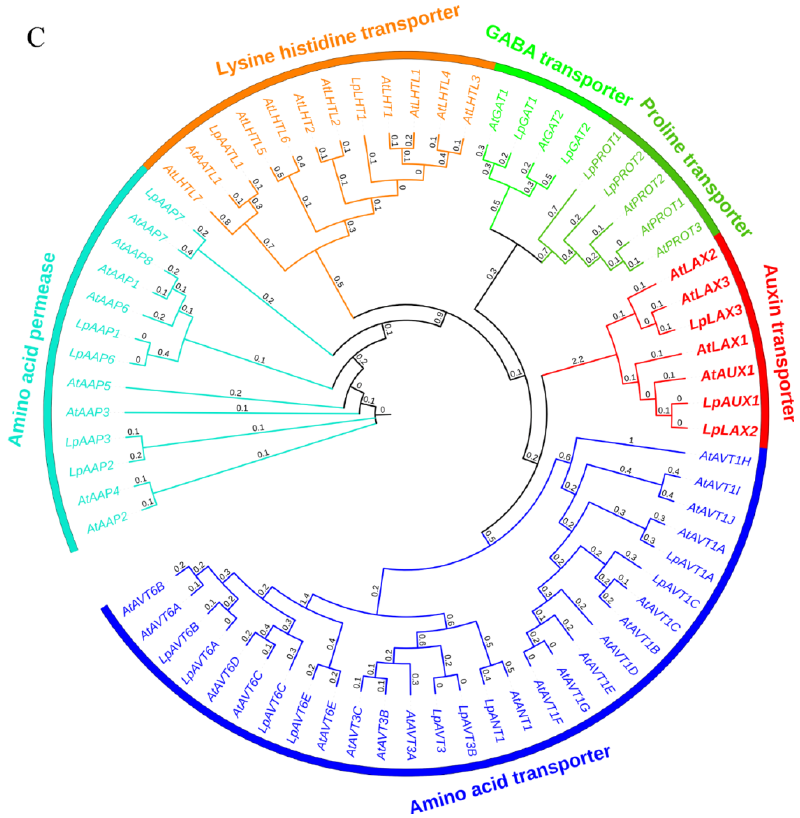
Figure 4. Phylogenetic relationships of members of the ATP-binding cassette (ABC), PIN/PILS and AUX/LAX families in Lilium pumilum (Lp) and Arabidopsis thaliana (At). ( A ) ABC family; ( B ) PIN/PILS family; ( C ) AUX/LAX family. Int. J. Mol. Sci. 2020 , 21 , x FOR PEER REVIEW